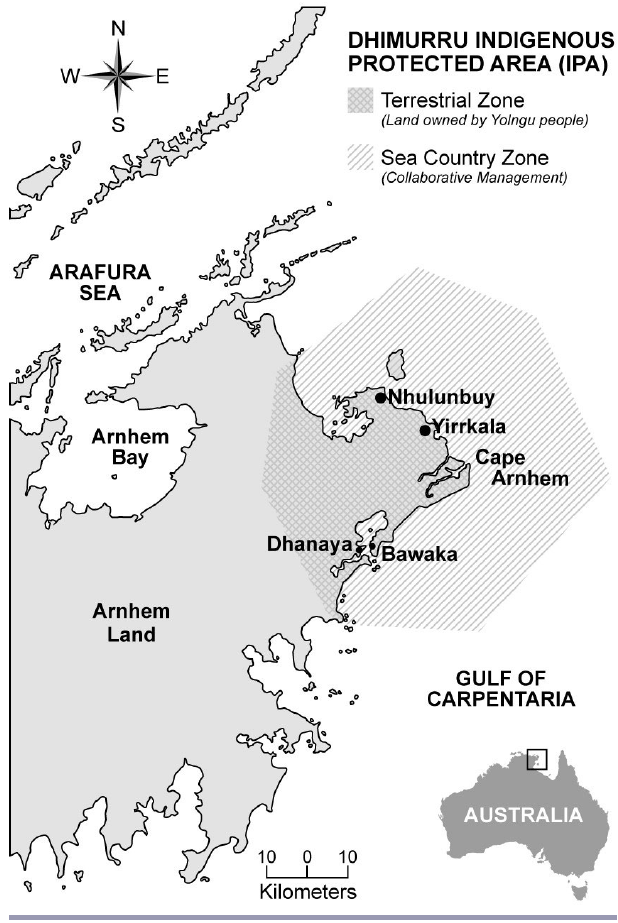
Fig. 1 . Map showing the location of the Dhimurru Indigenous Protected Area in the Northern Territory,